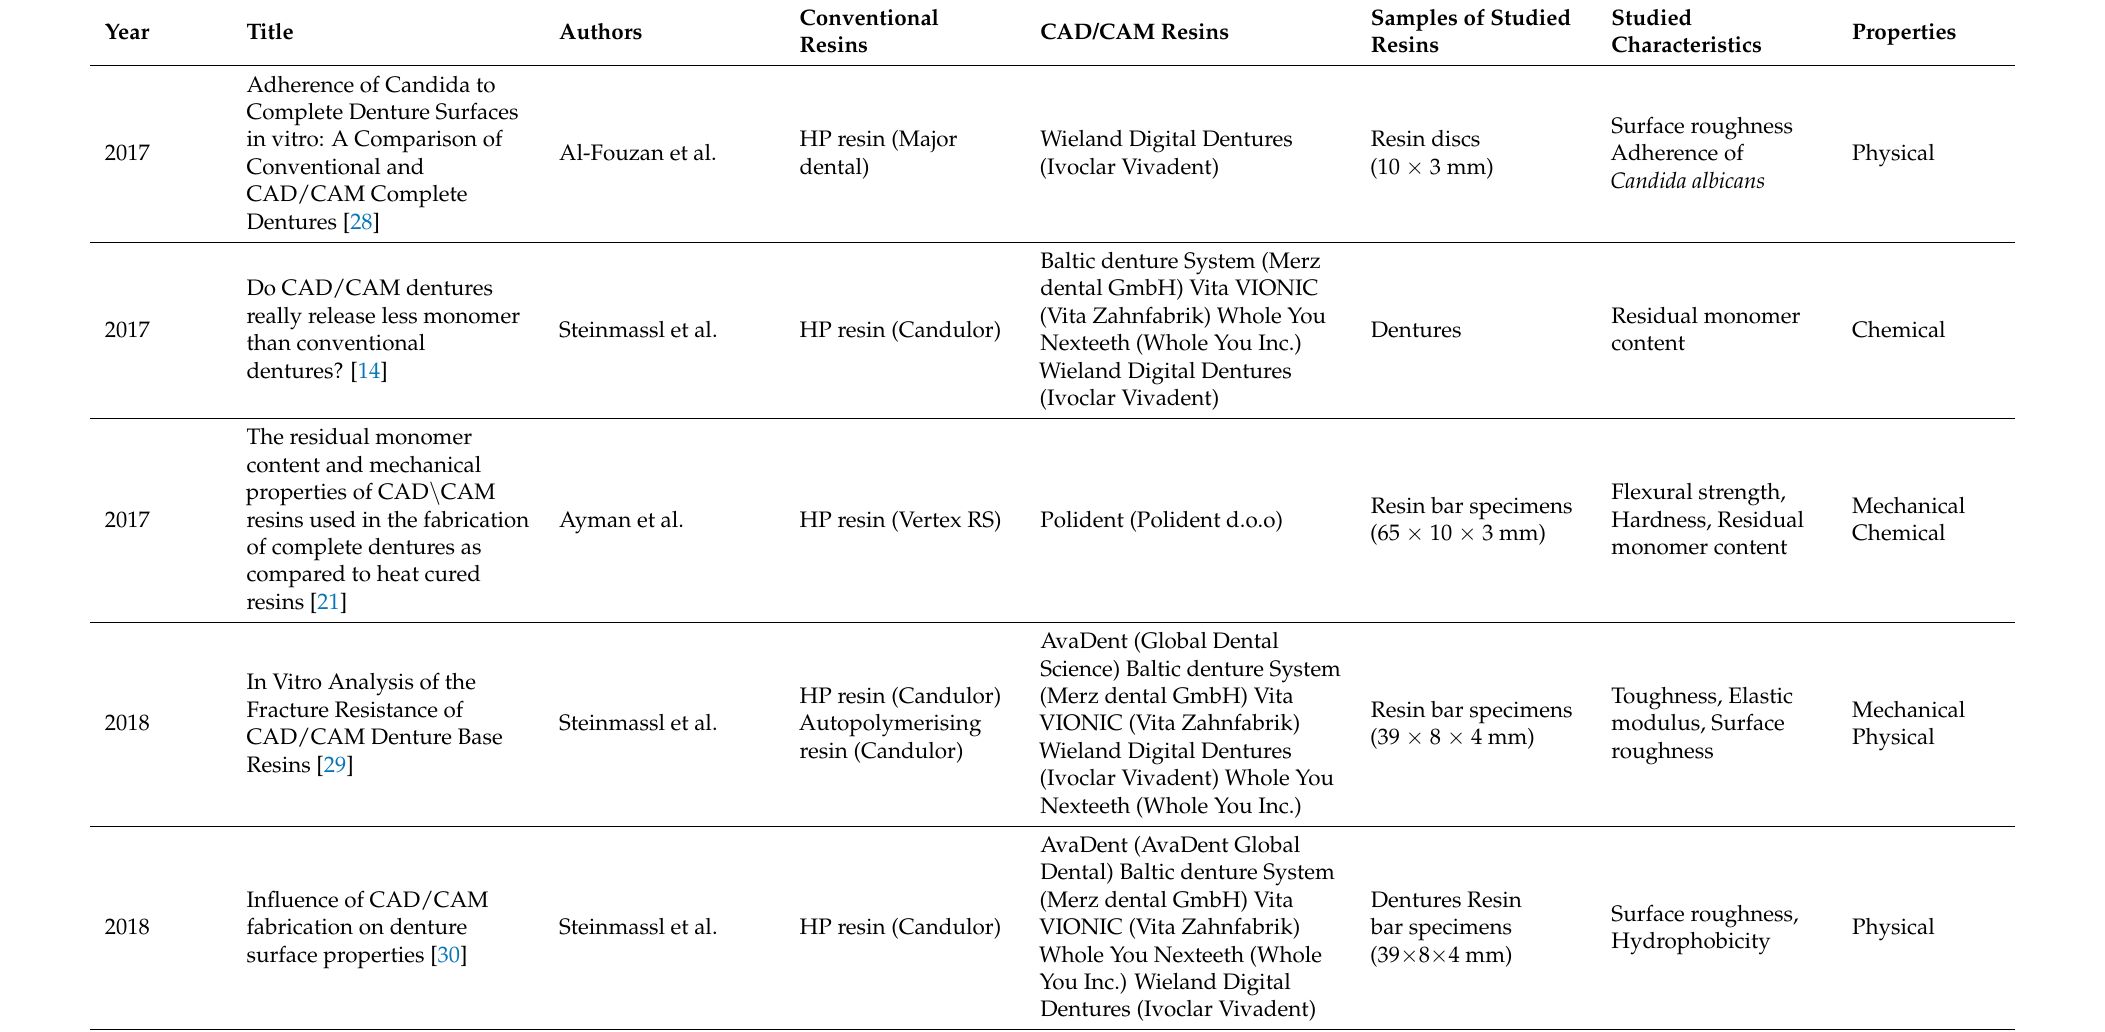
Table 1. Included articles (HP: Heat_polymerising; IM: Injected